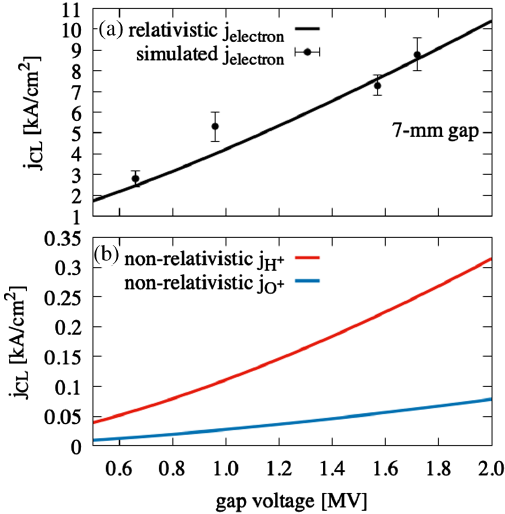
FIG. 3. Child-Langmuir current densities for (a) electrons and (b) H þ , and O þ . j and j are calculated using Eq. (14) for H þ O þ a 7-mm AK gap, and range from 39 . 3 – 314 A = cm 2 and 9 . 86 – 78 . 9 A = cm 2 , respectively. j is calculated using Eq. (15) and electron compared to an inner MITL simulation with only field-stress electron emission and thermal H þ emission. The simulated j fluctuates due to charge discretization, so an unweighted electron sliding-average smooth is applied. Error bars indicate the variation in the average value as the width of the sliding average is varied by 1.3